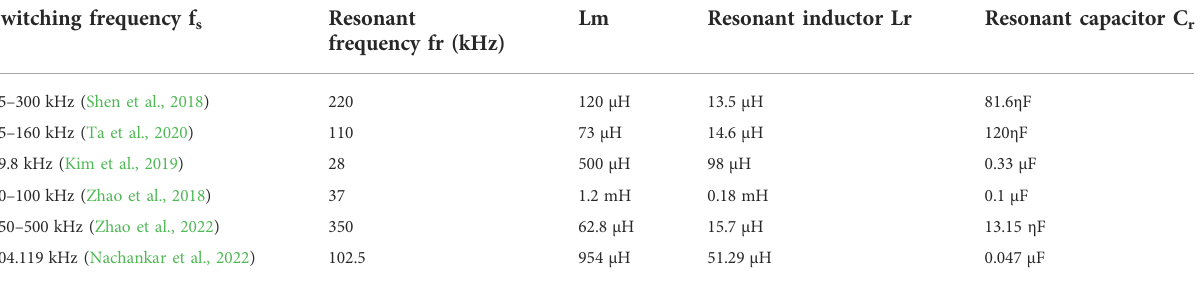
TABLE 5 LLC converter frequency range summary.